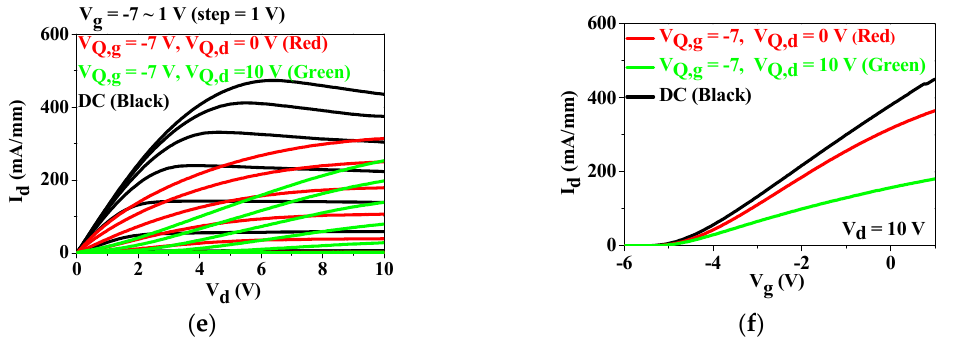
Figure 5. Pulsed I d - V d and I d -V g curves for the devices with R sh = ( a ), ( b ) 10 9 , ( c ), ( d ) 10 6 , and ( e ), ( f ) 10 4 sweeping V d = 0 ~ 10 V.